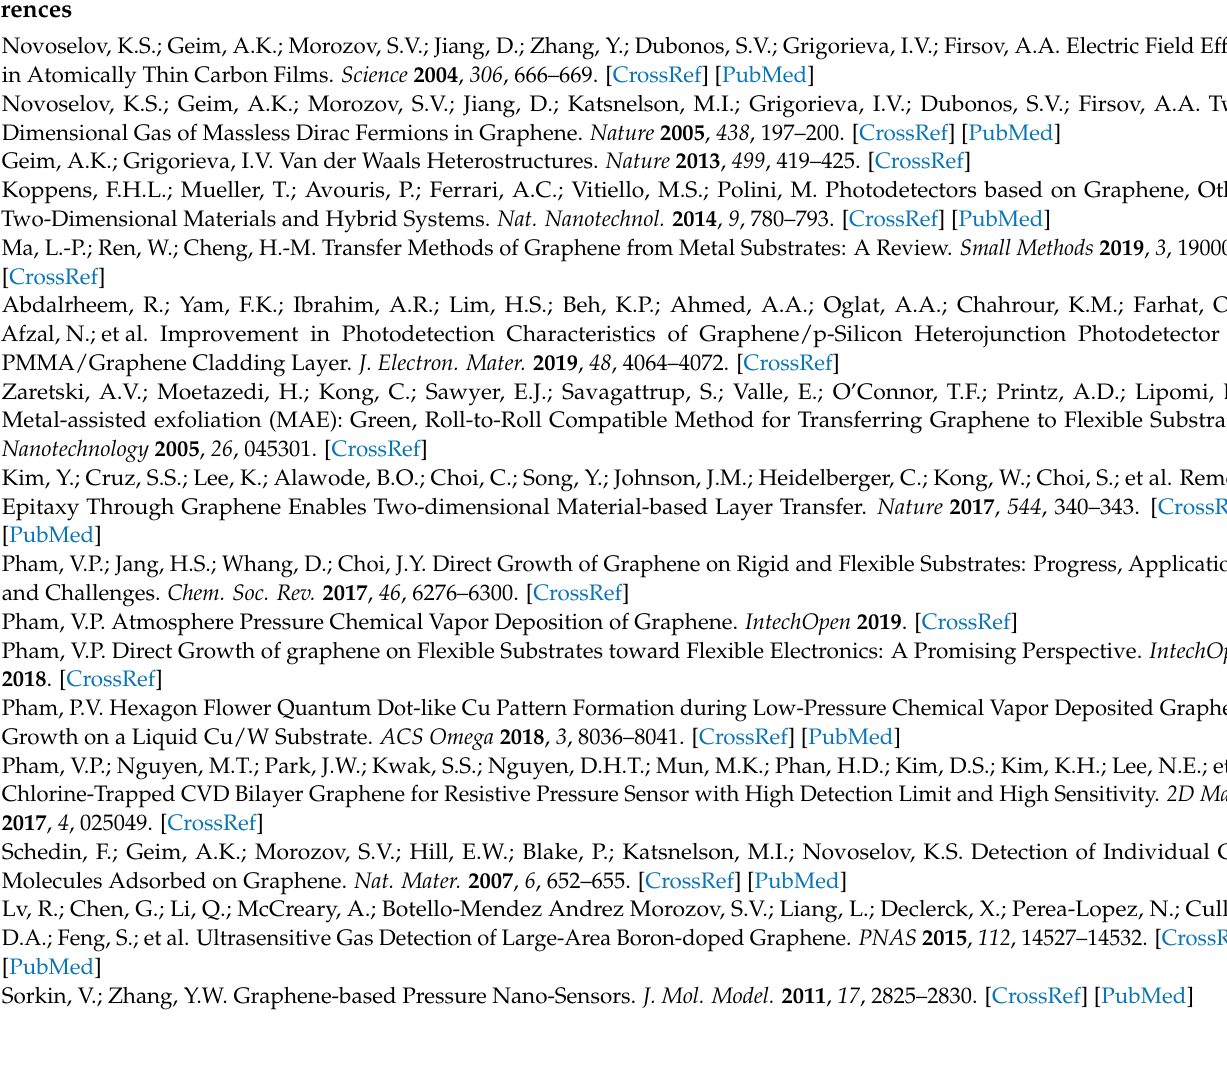
Cross-sectional TEM image of the as-fabricated nanofilm, Figure S3: Raman spectra of the as- fabricated nanofilm, Figure S4: SEM images of the nanofilm transferred onto the Si window via (a) IPA injection and N 2 blowing (deformable surface) and (b) DI water injection and vdW interaction (smooth surface), Figure S5: 3D AFM images of nanofilm transferred onto Si via (a) IPA injection and N 2 blowing (deformable surface) and (b) DI water injection and vdW interaction (smooth surface), Figure S6: Dark currents measured on various nanofilm-based photodetection devices for two transfer methods via (a) IPA injection and N 2 blowing (deformable surface) and (b) DI water injection and vdW interaction (smooth